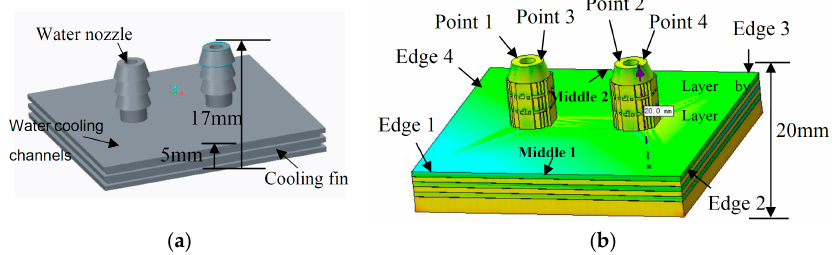
Figure 3. Chart of simulation model. ( a ) 3D Model; ( b ) the forming model.